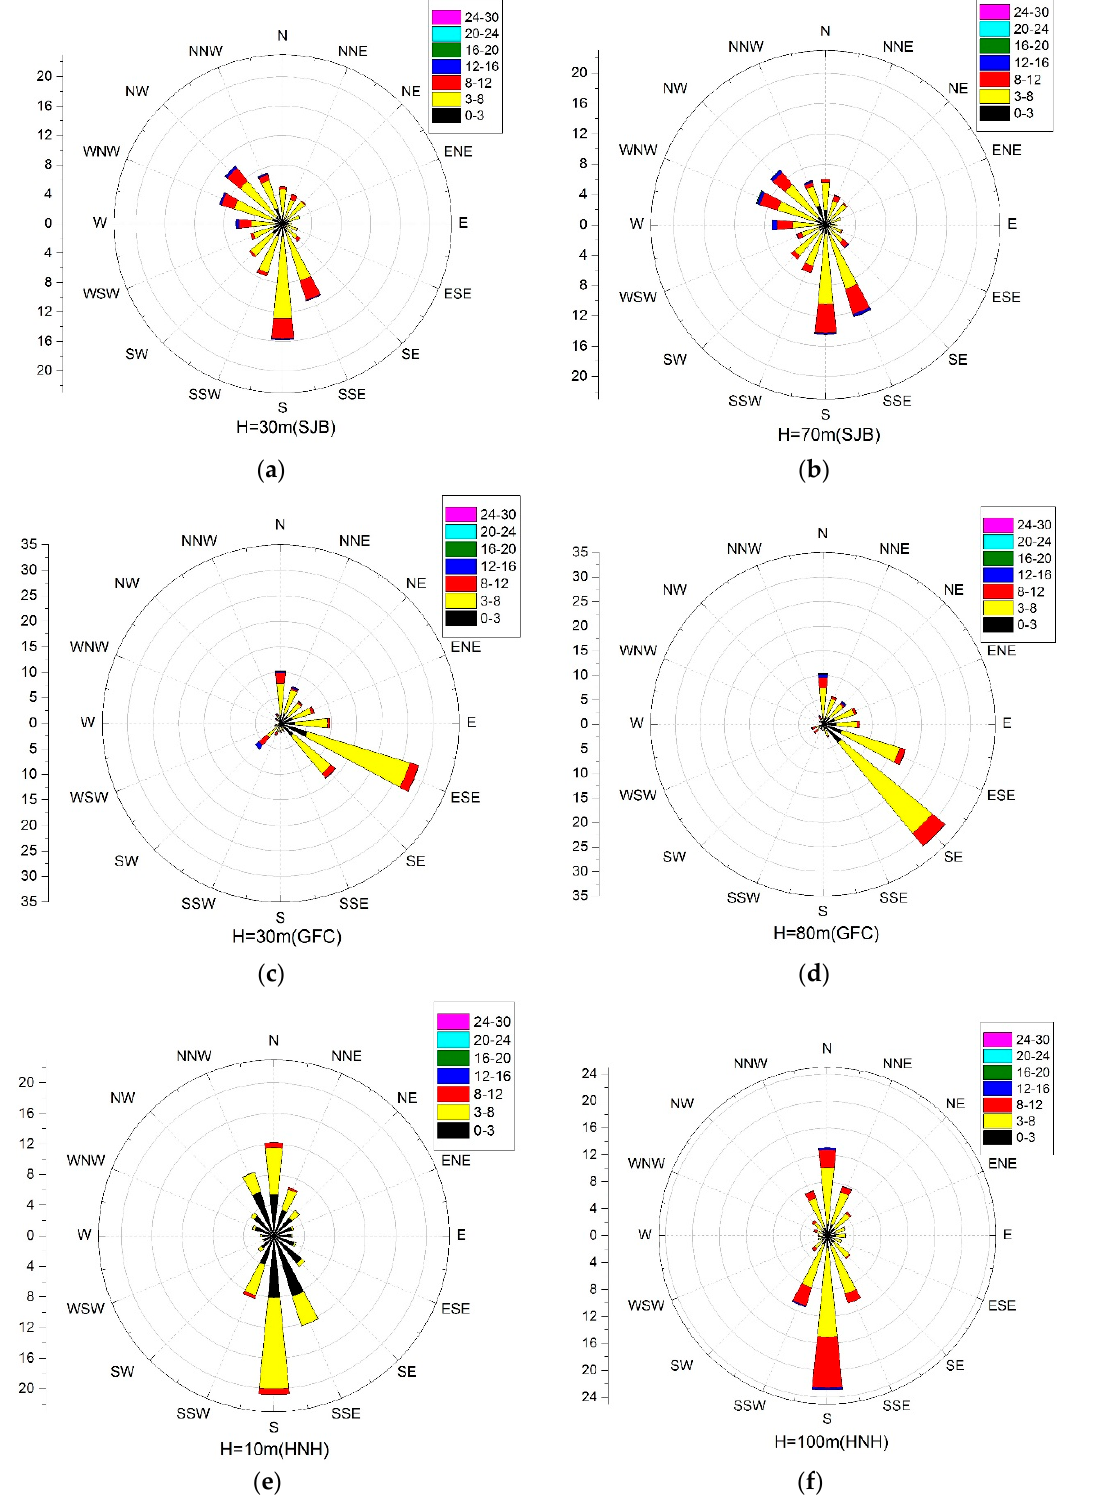
Figure 2. Wind rose measured at the three sites: ( a ) 30 m at SJB; ( b ) 70 m at SJB; ( c ) 30 m at GFC; ( d ) 80 m at GFC; ( e ) 10 m at HNH; ( f ) 100 m at HNH.